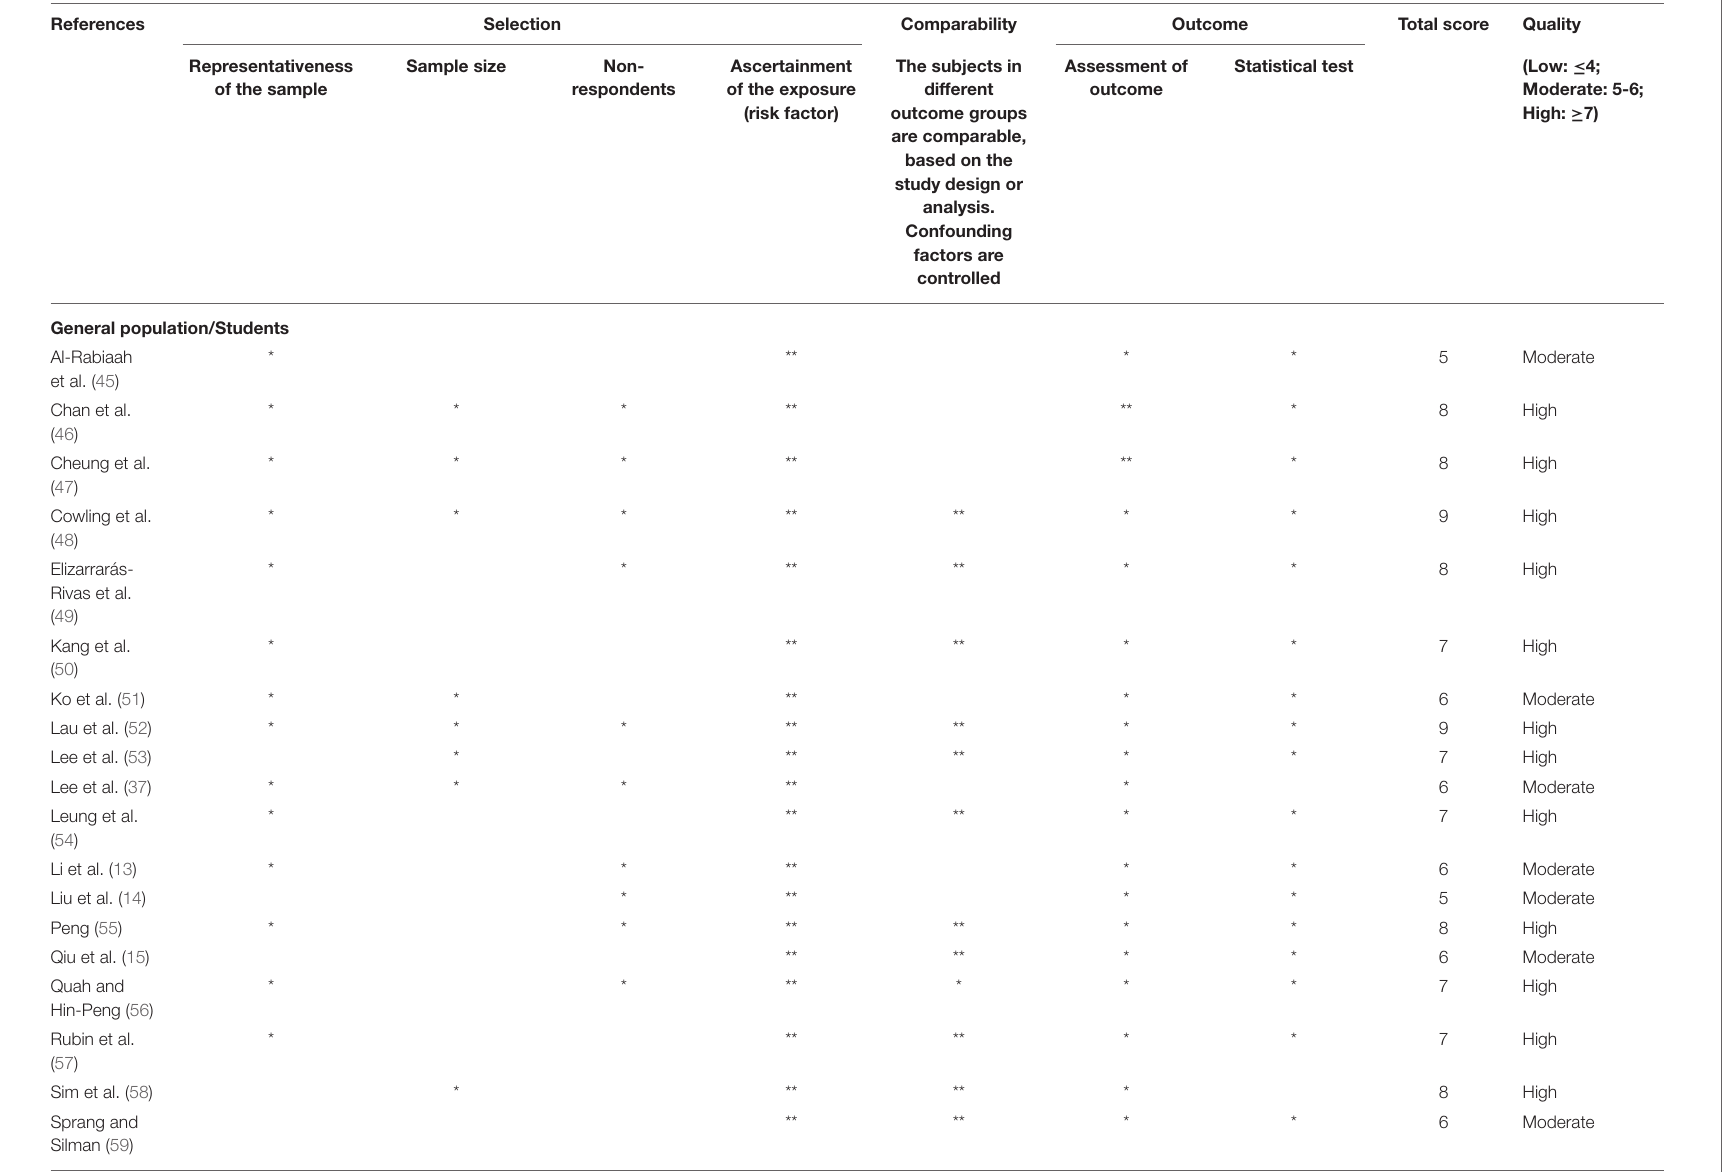
TABLE 5 | Newcastle–Ottawa Scale quality assessment for cross-sectional studies ( n =